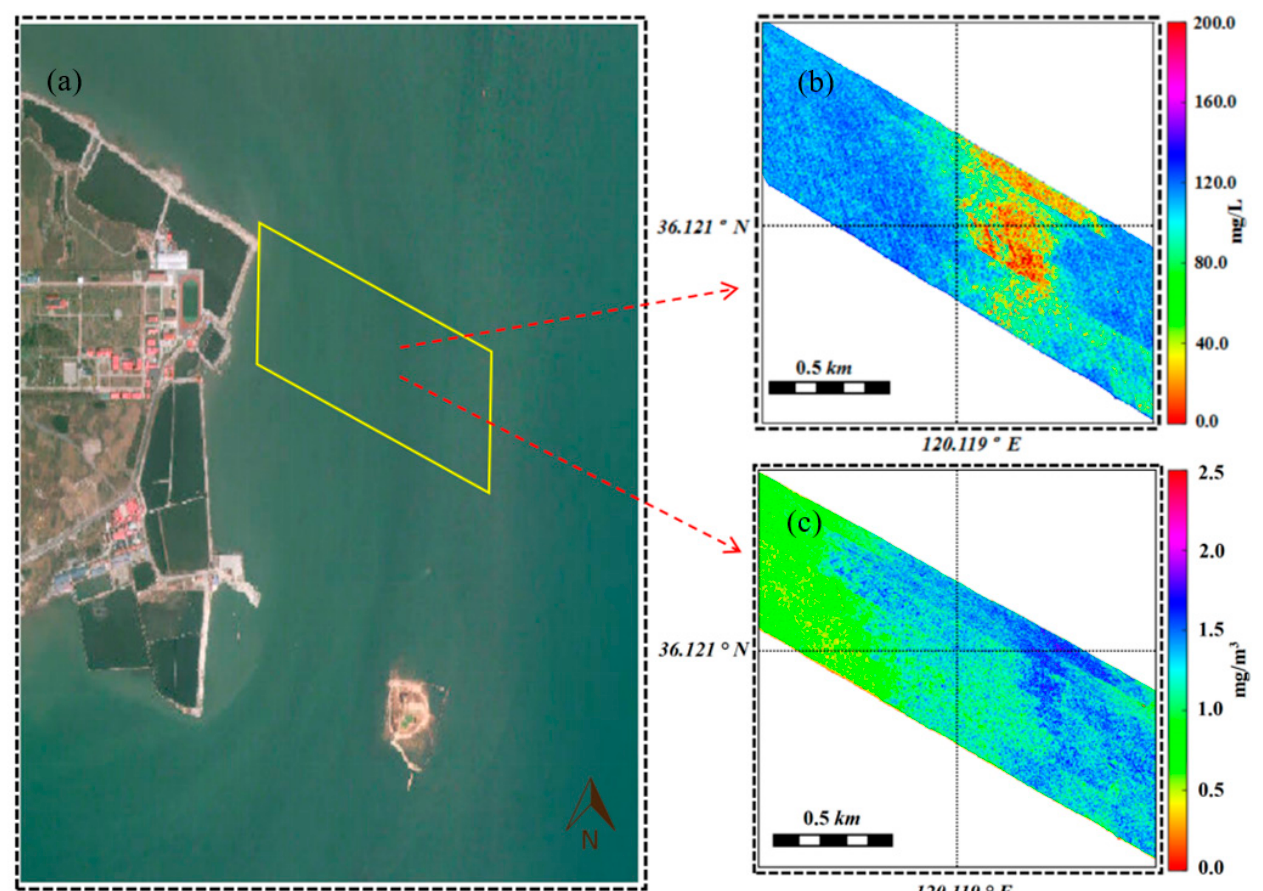
Figure 6. The study area ( a ) spatial distributions of the TSM ( b ) and Chl-a ( c ) concentrations in.